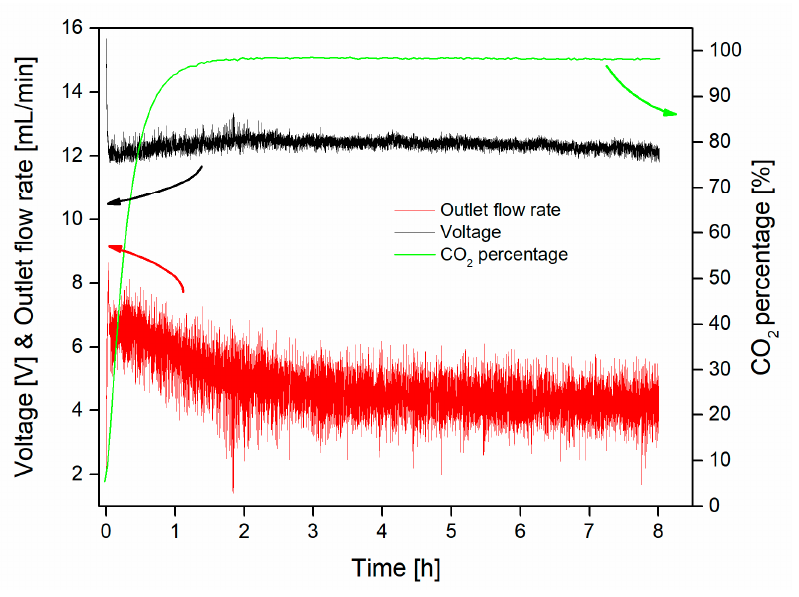
Figure 7. Measured voltage (left axis), CO 2 outlet flow rate, and purity of CO 2 in the outlet gas (right axis) during the stability test of eight hours (experimental conditions: Q inlet = 20 mL/min, Q pump = 1 mL/min, J = 100 mA/cm 2 , CO 2 /N 2 ratio = 100%/0%).